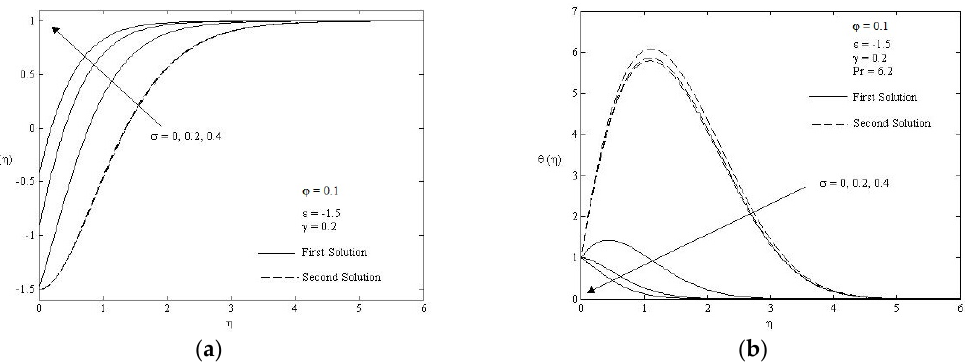
Figure 5. Skin friction 𝑓 (cid:4593)(cid:4593) (cid:4666) 0 (cid:4667) ( a ) and heat transfer coefficient (cid:3398)𝜃 (cid:4593) (cid:4666) 0 (cid:4667) ( b ) vs. 𝜀 for particular val ‐ Figure 6. Dual velocity 𝑓 (cid:4593) (cid:4666)𝜂(cid:4667) ( a ) and temperature profile 𝜃(cid:4666)𝜂(cid:4667) ( b ) for particular values of 𝜎 . Figure 6. Dual velocity f (cid:48) ( η ) ( a ) and temperature profile θ ( η ) ( b ) for particular values of σ . ues of 𝜑 .